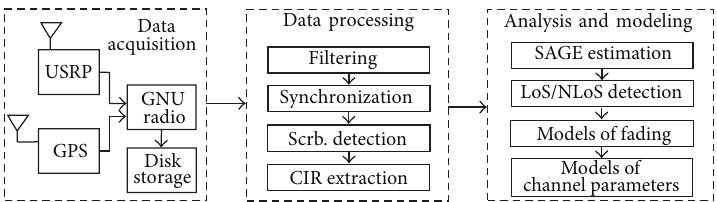
Figure 1: A diagram of channel measurement, data analysis, and modeling procedure adopted for LoS/NLoS channel characterization. [16–18], was adopted for LoS detection in the early stage.